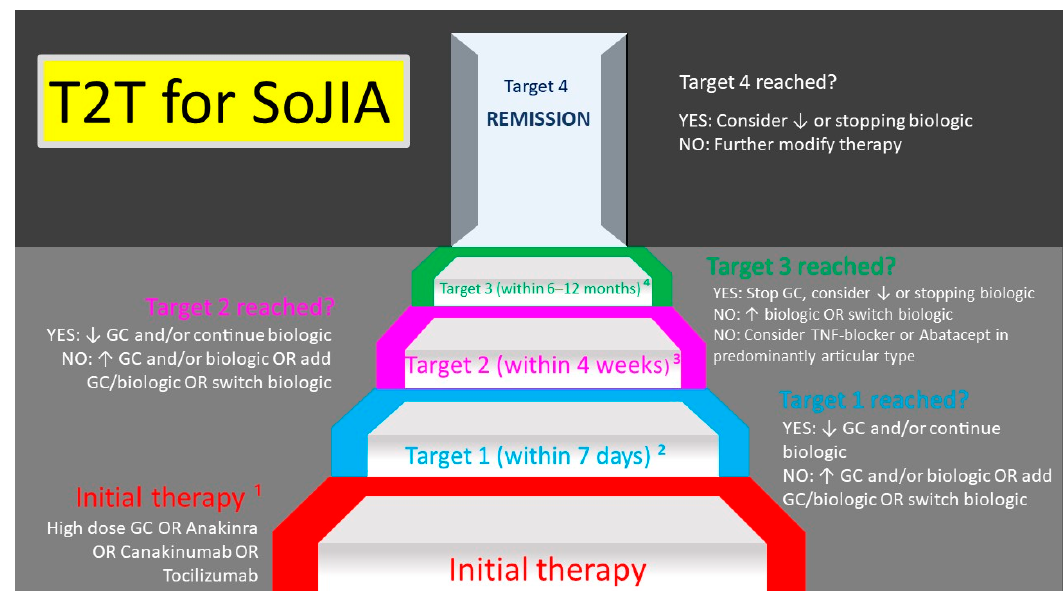
Figure 2. Treat-to-target consensus treatment strategy from the German Society for Pediatric Rheumatology for definitive SoJIA. In addition, non-steroidal anti-inflammatory drugs, intraarticular GC or Methotrexate may be used throughout. 1 Maximal doses for glucocorticoids: intravenous methylprednisolone pulse therapy (20–30 mg/kg/day (max. 1000 mg/day) for 5 days or prednisolone equivalent 1–2 mg/kg/day (max. 80 mg/day). Maximal doses for biologics: Anakinra 8 mg/kg/day (max. 300 mg/day), Canakinumab max. 300 mg every 4 weeks, Tocilizumab (for body weight >30 kg) 8 mg/kg (max. 800 mg) i.v. every 2 weeks and (for body weight <30 kg) 12 mg/kg every 2 weeks. 2 Treatment target 1-definition: resolution of fever or improvement of CRP by at least 50%. 3 Treatment target 2-definition: improvement of the physician global assessment by at least 50% AND reduction of the active joint count by at least 50% OR JADAS-10 score of maximally